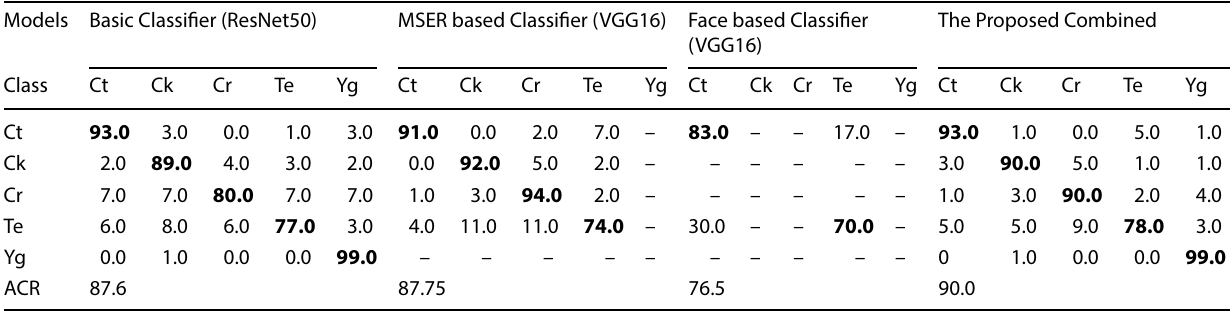
Bold indicates the best